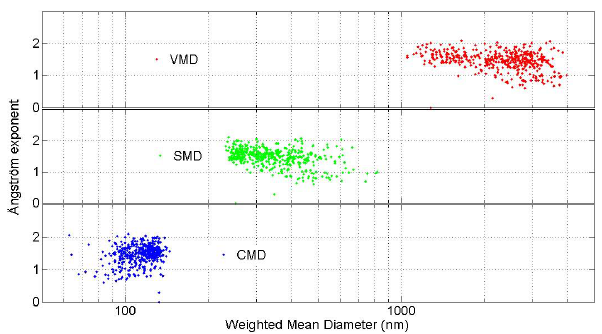
Fig. 11. Relationships between scattering ˚Angstr¨om exponents and three parameters calculated from sub micrometer aerosol parti- cle number size distributions (10–500nm): count mean diameter (CMD), surface area mean diameter (SMD) and volume mean di- ameter (VMD). The plots comprise measurements taken between July and August